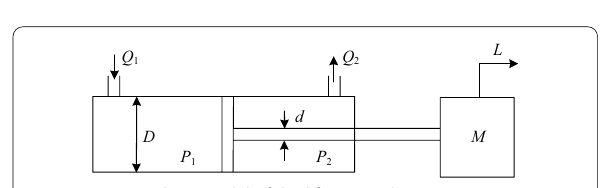
Figure 3 Equivalent model of the lifting